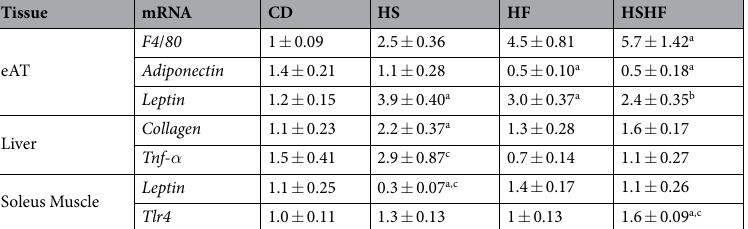
Table 2. mRNA expression of inflammatory genes in insulin-responsive tissues: adipose tissue, liver and skeletal muscle from mice fed the control diet (2) or obesogenic diets: high-sugar (HS), high-fat (HF) and high-sugar/high-fat diet (HSHF) for eight weeks. mRNA gene expression in the epididymal adipose tissue (n = 6–7/group; Rplp0 as housekeeping gene), liver (n = 10–12/group; 18 S as housekeeping gene) and soleus muscle (n = 6–7/group; 18 S as housekeeping gene). The results are expressed as the mean ± S.E.M. (a) P < 0.05 compared with CD, (b) P < 0.05 compared with HC, and (c) P < 0.05 compared with HF using one-way ANOVA and Tukey’s post-test. CD, control diet; HS, high-sugar diet; HF, high-fat diet; HSHF, high-sugar/high- fat diet; Tnf –tumour necrosis factor; Tlr4 , Toll-like receptor